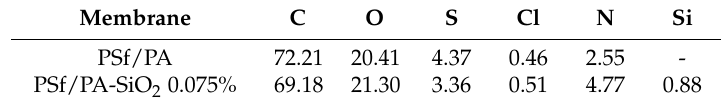
Table 1. Atomic ratio of different element in the PSf /PA membrane and PSf/PA-SiO 2 membrane.